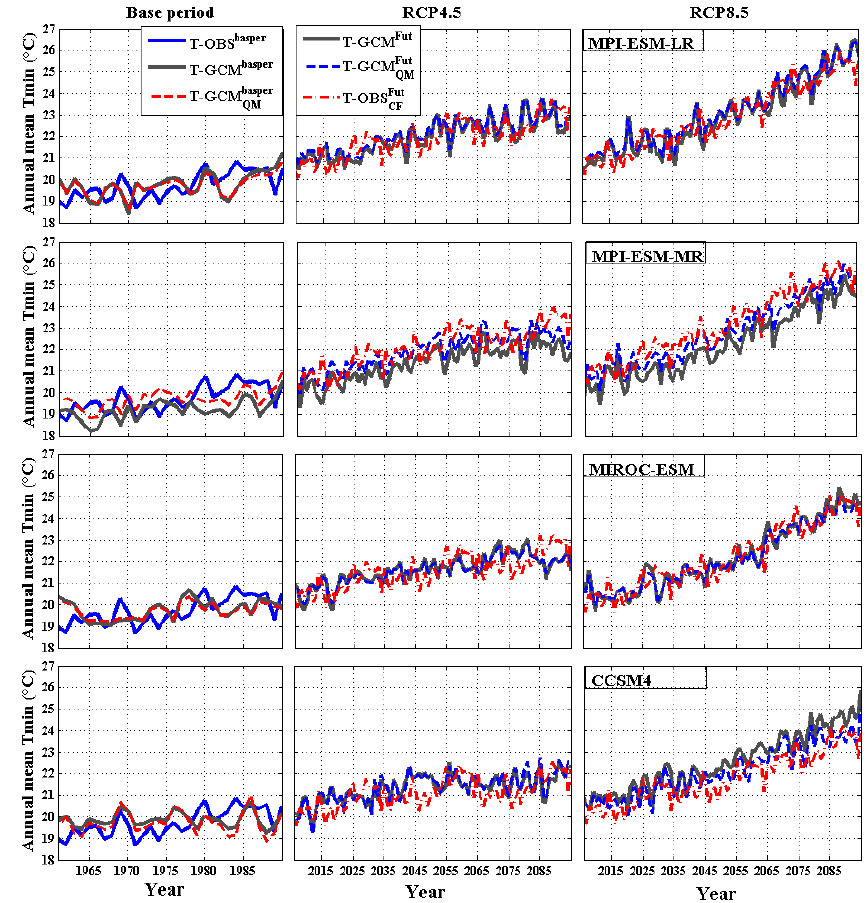
Figure 8. As in Fig. 7 but for the T min